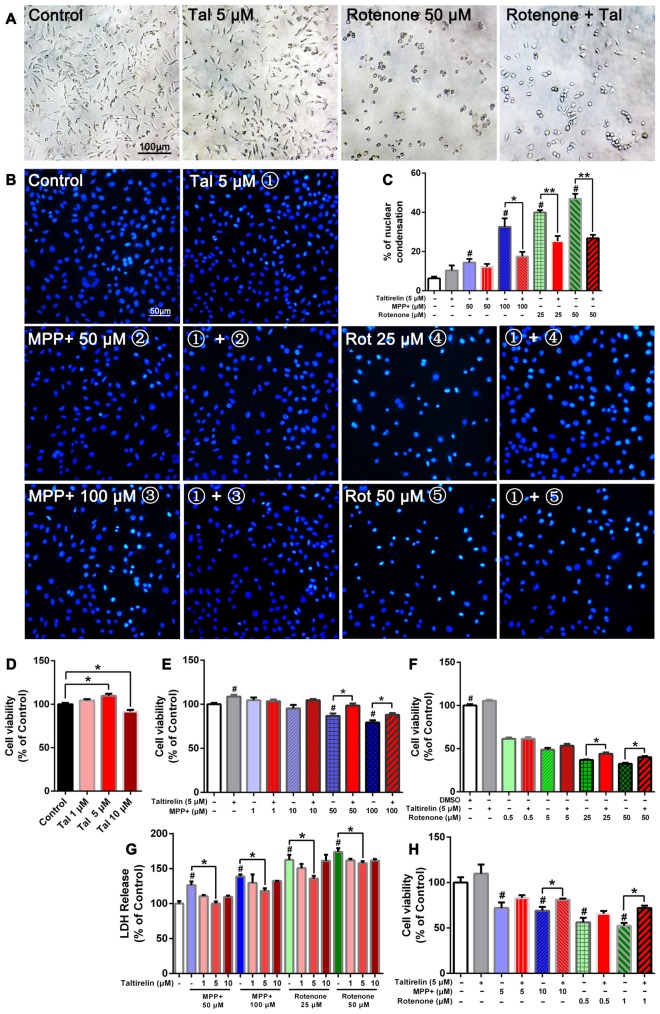
Taltirelin protected dopaminergic neurons from toxicity of MPP+ and rotenone. SH-SY5Y cells were pre-treated with Taltirelin (5 μM) for 2 h and incubated another 24 h with MPP+ (1, 10, 50 or 100 μM) or rotenone (0.5, 5, 25 or 100 μM; (A) phase contrast micrograph of cultured SH-SY5Y cells exposed to rotenone (50 μM) for 24 h. (B) Hoechst 33342 staining of SH-SY5Y cells. (C) The percentage of nuclear condensation in total cell population as measured by Hoechst 33342 staining. (D–F) SH-SY5Y Cell viability was measured by MTT assay after intervention. (G) Lactate dehydrogenase (LDH) release assay was used to determine the cell death rate of SH-SY5Y cells. (H) Viability of primary midbrain neurons was assessed by MTT assay. #p < 0.05 vs. Control; *p < 0.05; **p < 0.01. N = 6. Error bars represent SEM.